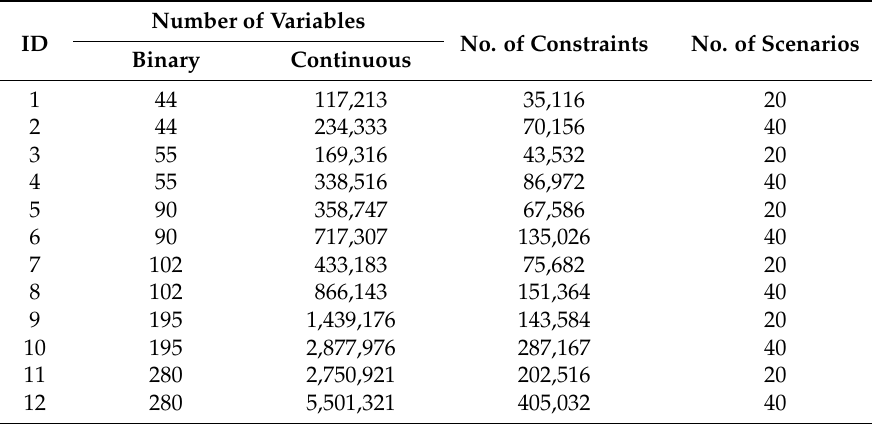
Table 5. Number of variables and constraints in each test